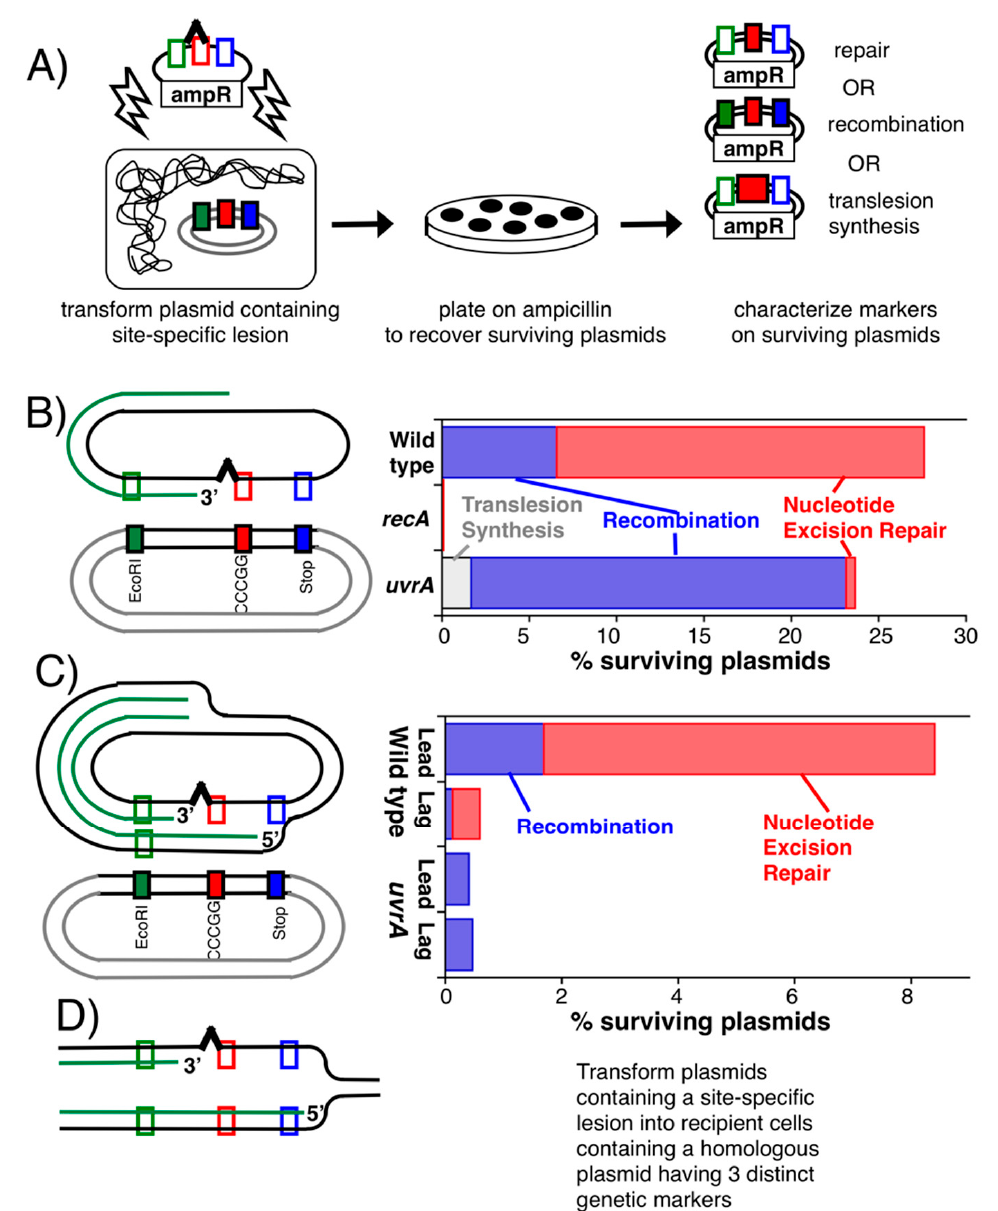
Figure 10. Nucleotide excision repair occurs at disrupted replication forks. ( A ) Schematic to measure lesion processing on replicating plasmids . Plasmids containing a site-specific AAF adduct were trans- formed into cells containing a second endogenous, homologous plasmid with three closely spaced, genetic markers. The markers are designed to allow one to determine whether nucleotide excision repair (surviving plasmids only contained the marker at the lesion site), recombination (surviving plasmids contained multiple genetic markers), or translesion synthesis (contained a base-pair inser- tion at the middle marker) occurred on the surviving plasmids that are recovered. ( B ) Nucleotide excision repair events predominate at disrupted replication forks . When single-stranded plasmids were used in this assay, nucleotide excision repair predominated over recombination events. Few plasmids were recovered in recA mutants. In the absence of nucleotide excision repair, survival was reduced and recombination events predominated. ( C ) Nucleotide excision repair occurs when the lesion is in the leading strand, which disrupts replication, but not the lagging strand, which does not disrupt repli- cation . The same assay is repeated as in ( B ), except transforming a double-stranded plasmid con- taining an AAF adduct in either the leading- or lagging-strand template. In wild-type cells, nucleo- tide excision repair events predominated on the recovered plasmids when the lesion was in the leading strand. When the lesion was in the lagging strand the frequency of repair and plasmids recovered was severely reduced. In uvrA mutants, the frequency of plasmids recovered was severely reduced irrespective of whether the lesion was in the leading- or lagging-strand template and re- combination events predominated. ( D ) To be scored in this assay, repair events were required to undergo strand exchange and utilize an intermolecular template for repair. In vivo, the template uti- lized for repair would be intramolecular, as shown, allowing the reaction to occur with far, far greater fre- quency and efficiency . Composed and drawn from data reported in [83,84].